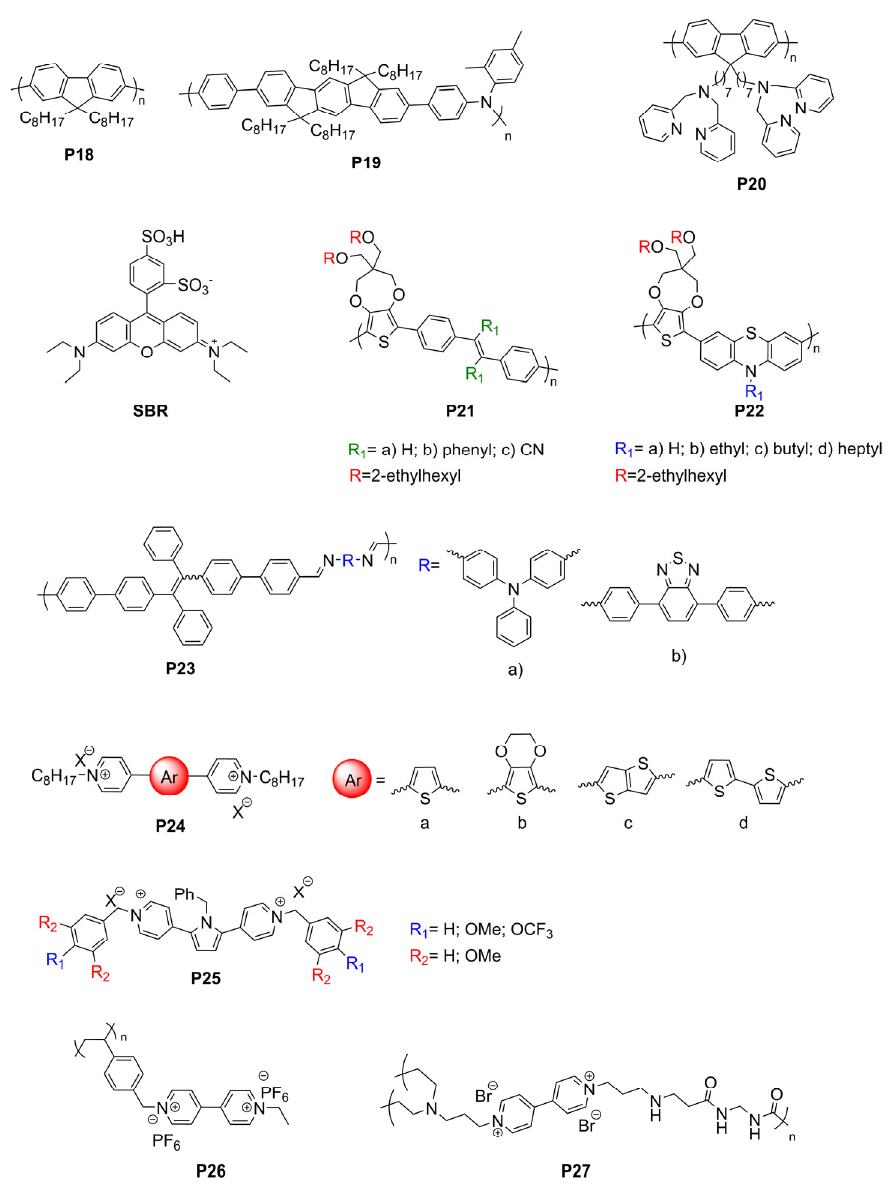
Figure 18. Recent conjugated and viologen ‐ based EFC polymers [60,154,169–175].